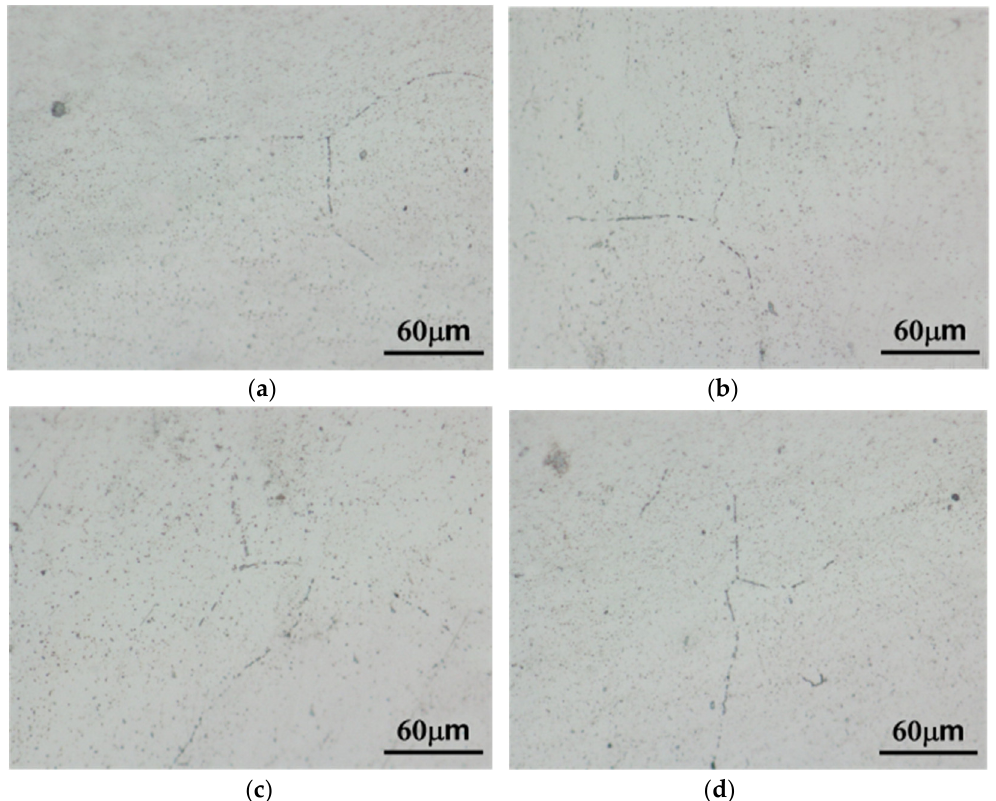
Figure 4. Optical photomicrographs of as-cast ( a ) alloy A , ( b ) alloy B , ( c ) alloy C and ( d ) alloy D after immersion in phosphoric acid solution.